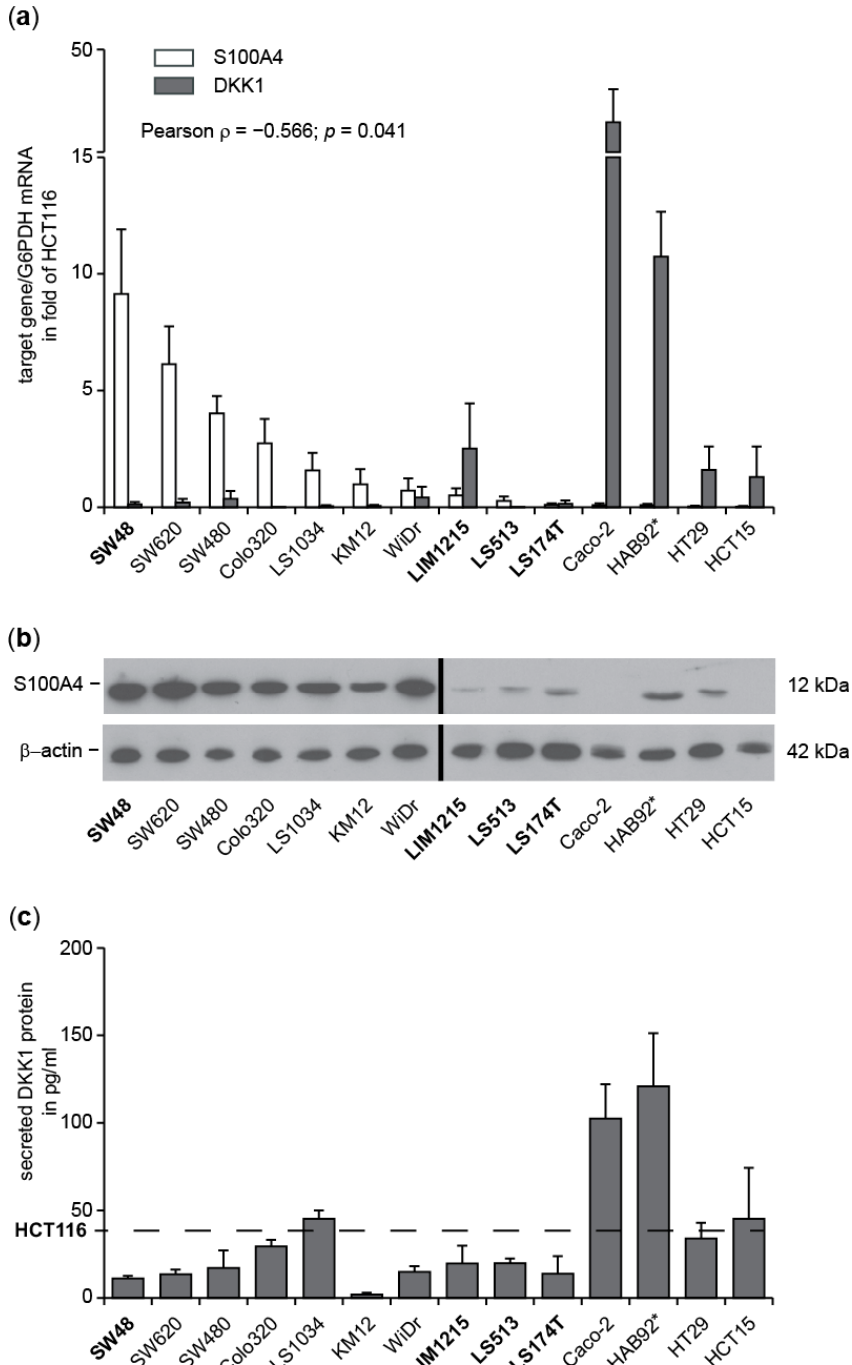
Figure 3. Inverse expression correlation of S100A4 and DKK1 in a panel of 13 CRC cell lines. ( a ) Relative mRNA expression level of S100A4 and DKK1 determined by gene-specific qRT PCR. ( b ) Western blot analysis of S100A4 expression. GAPDH served as loading control. ( c ) ELISA of extracellular amounts of human DKK1 in culture medium in the fold of HCT116. Names in bold indicate mutated β -catenin: HCT116—S45 Δ , SW48—S33Y, LIM1215—T41A, LS513—A5-80 Δ , LS174T—S45F. * indicates wt for both APC and β -catenin (Figure S1e–h).